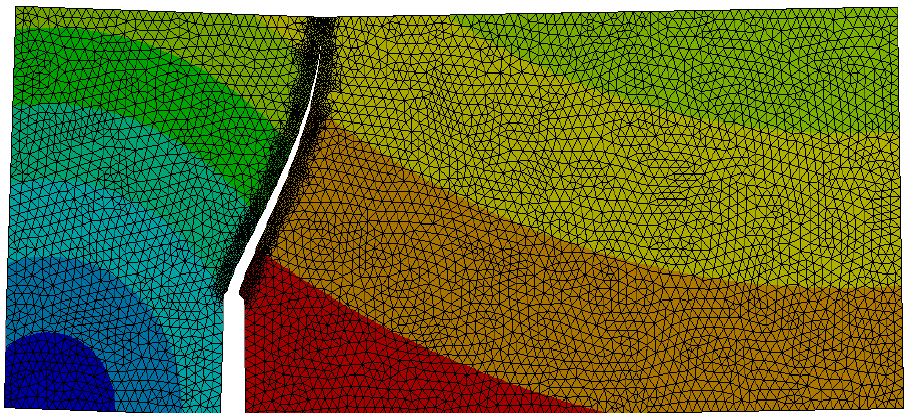
Figure 20. Predicted crack growth trajectory for specimen 6.